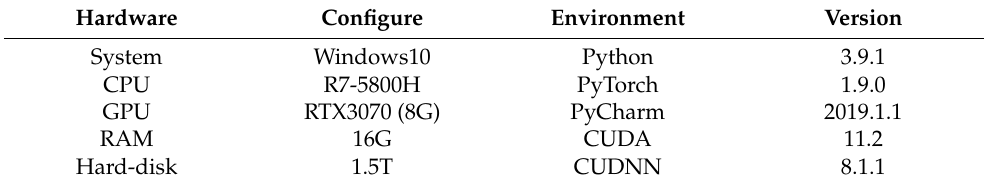
Table 2. Hardware configuration and operating environment.